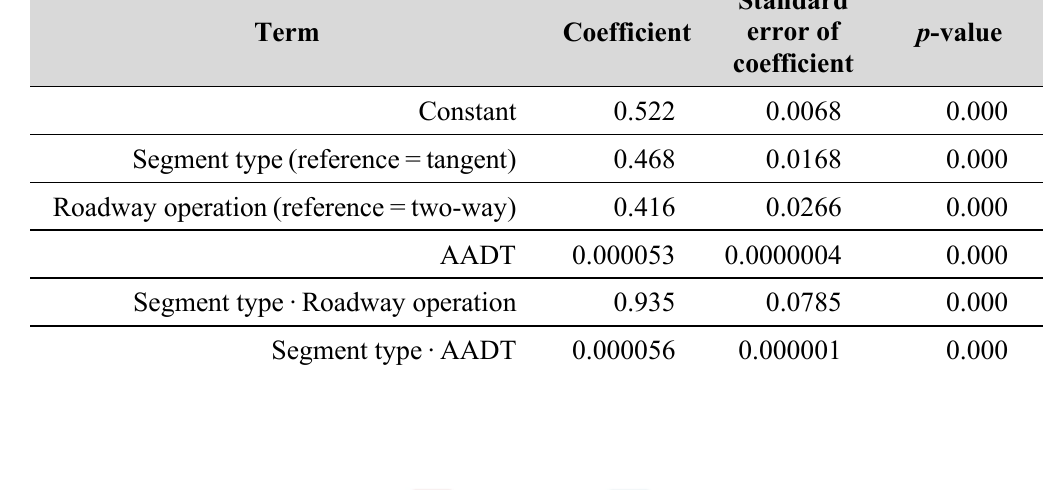
Table 1 Model coefficient summary